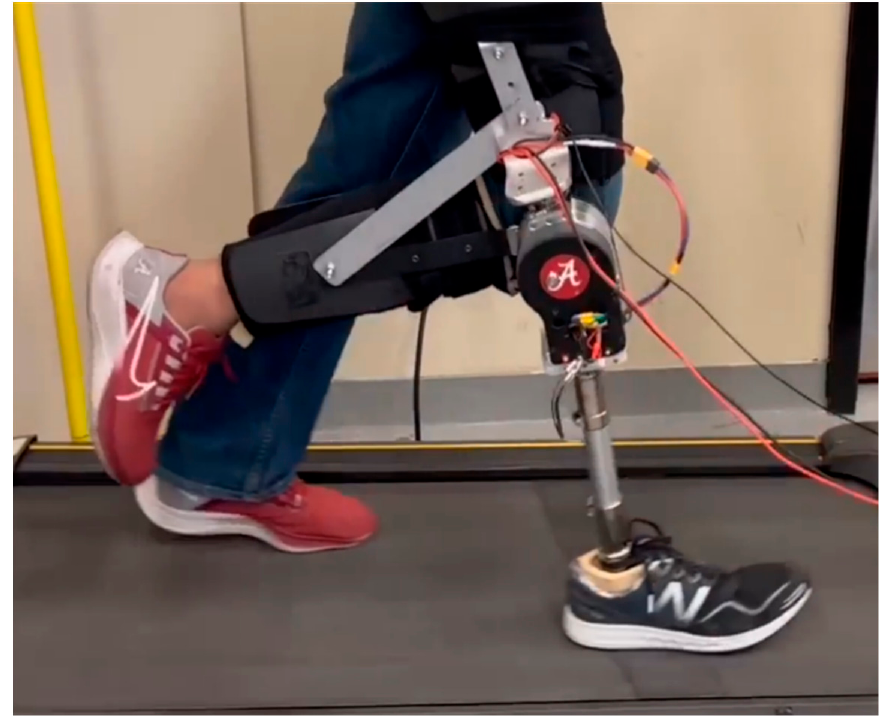
Figure 10. Prosthesis fitted with the FM-PLS sensor prototype.